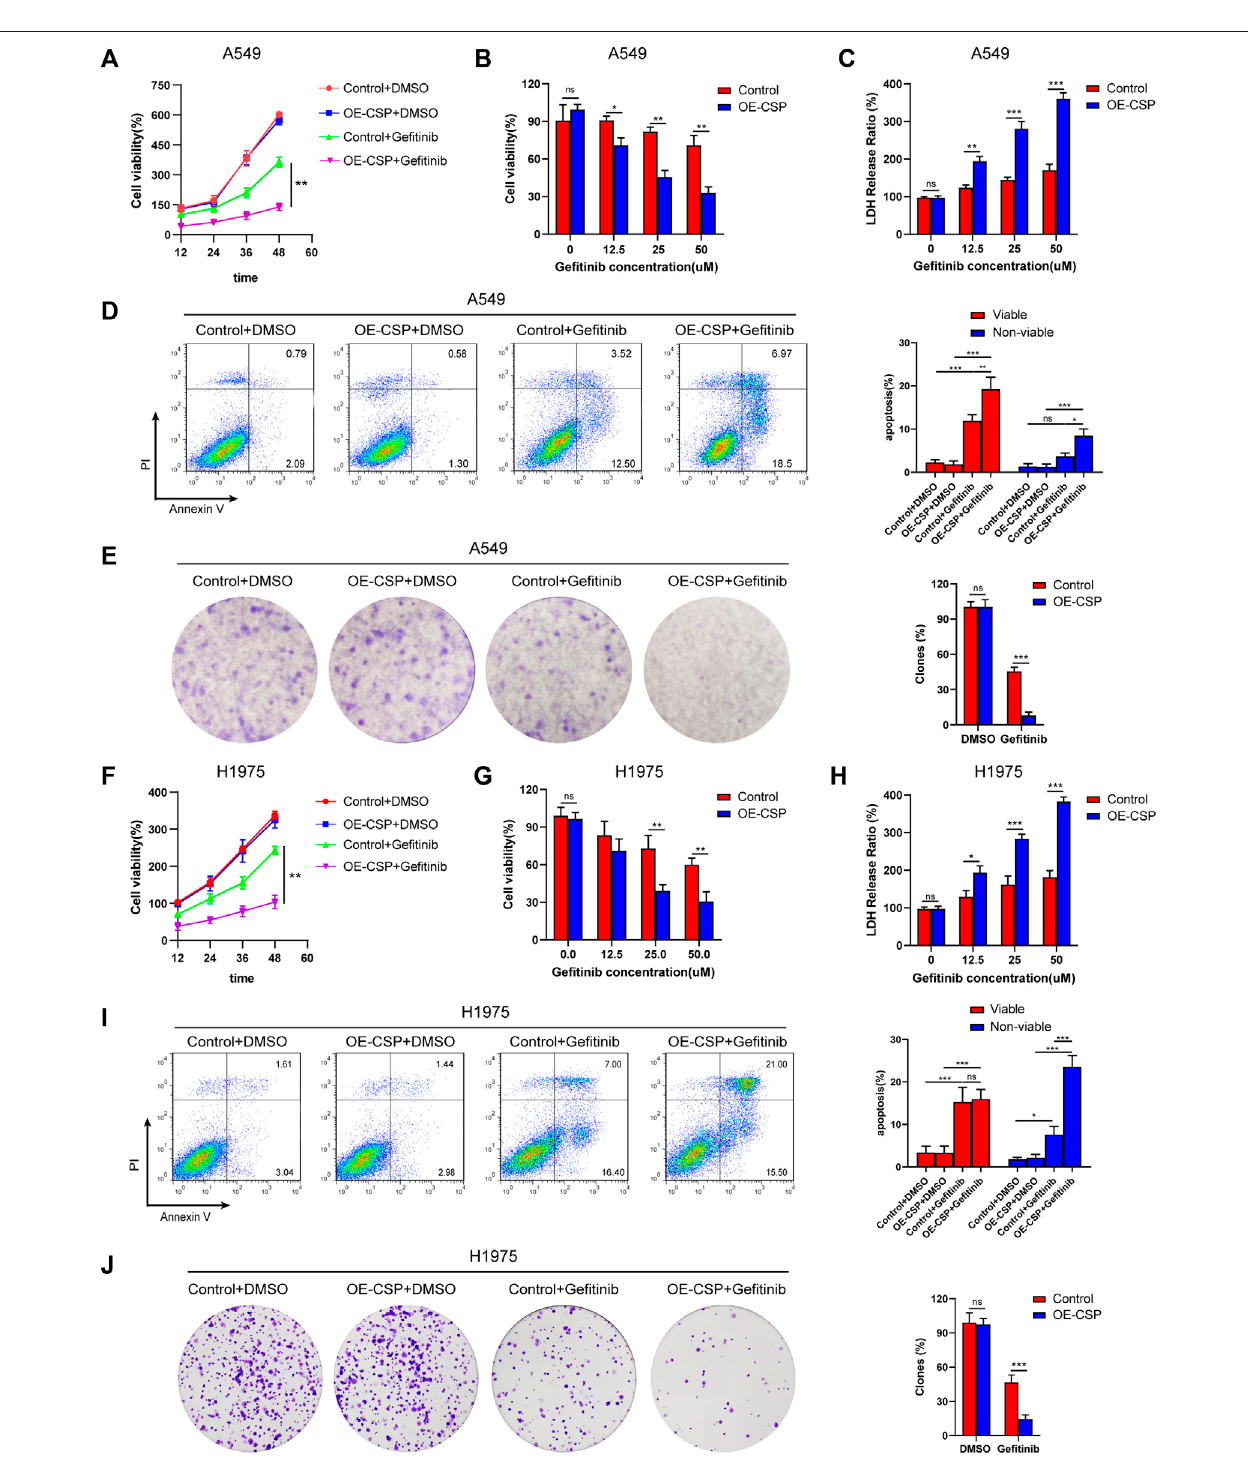
FIGURE 1 | Overexpression of circumsporozoite protein (CSP) facilitated cytotoxicity caused by ge fi tinib. Control and OE-CSP A549 (A) and H1975 (F) cells (2 × 10 3 ) were seededin96-wellplatesandtreatedwithge fi tinib.Cellviabilitywasassessedat12 hintervals.A549 (B) andH1975 (G) cellsweretreatedwiththeindicatedconcentrationofge fi tinibfor 24 h,andtheirviabilitywasdeterminedusingaCCK8kitandthelactatedehydrogenaseassay (C,H). Next,controlandOE-CSPA549 (D) andH1975 (I) cells(5×10 5 )werestained withAnnexinVandpropidiumiodideaftertreatmentwithge fi tinib.Theapoptosisrateintheearlyandlatestageswasdetectedby fl owcytometry.Representativeimagesfor fl ow cytometry( left )andstatisticalhistograms( right ).Viable,earlyapoptoticcells;non-viable,lateapoptoticcells.ControlandOE-CSPA549 (E) andH1975 (J) cells(1×10 3 )werethen fi xed in 4% paraformaldehyde and stained with 0.1% crystal violet solution. After incubation for 7 days, the colony number was analyzed using ImageJ software. The clone rate (%) was normalizedtothecontrolgroup(DMSO).Representativeimagesforcolonyanalysis( left )andstatisticalhistograms( right ).Thedataarepresentedasthemean±standarddeviationof three independent experiments in vitro (ns, not statistically signi fi cant, * p < 0.05, ** p < 0.01, and *** p < 0.001).